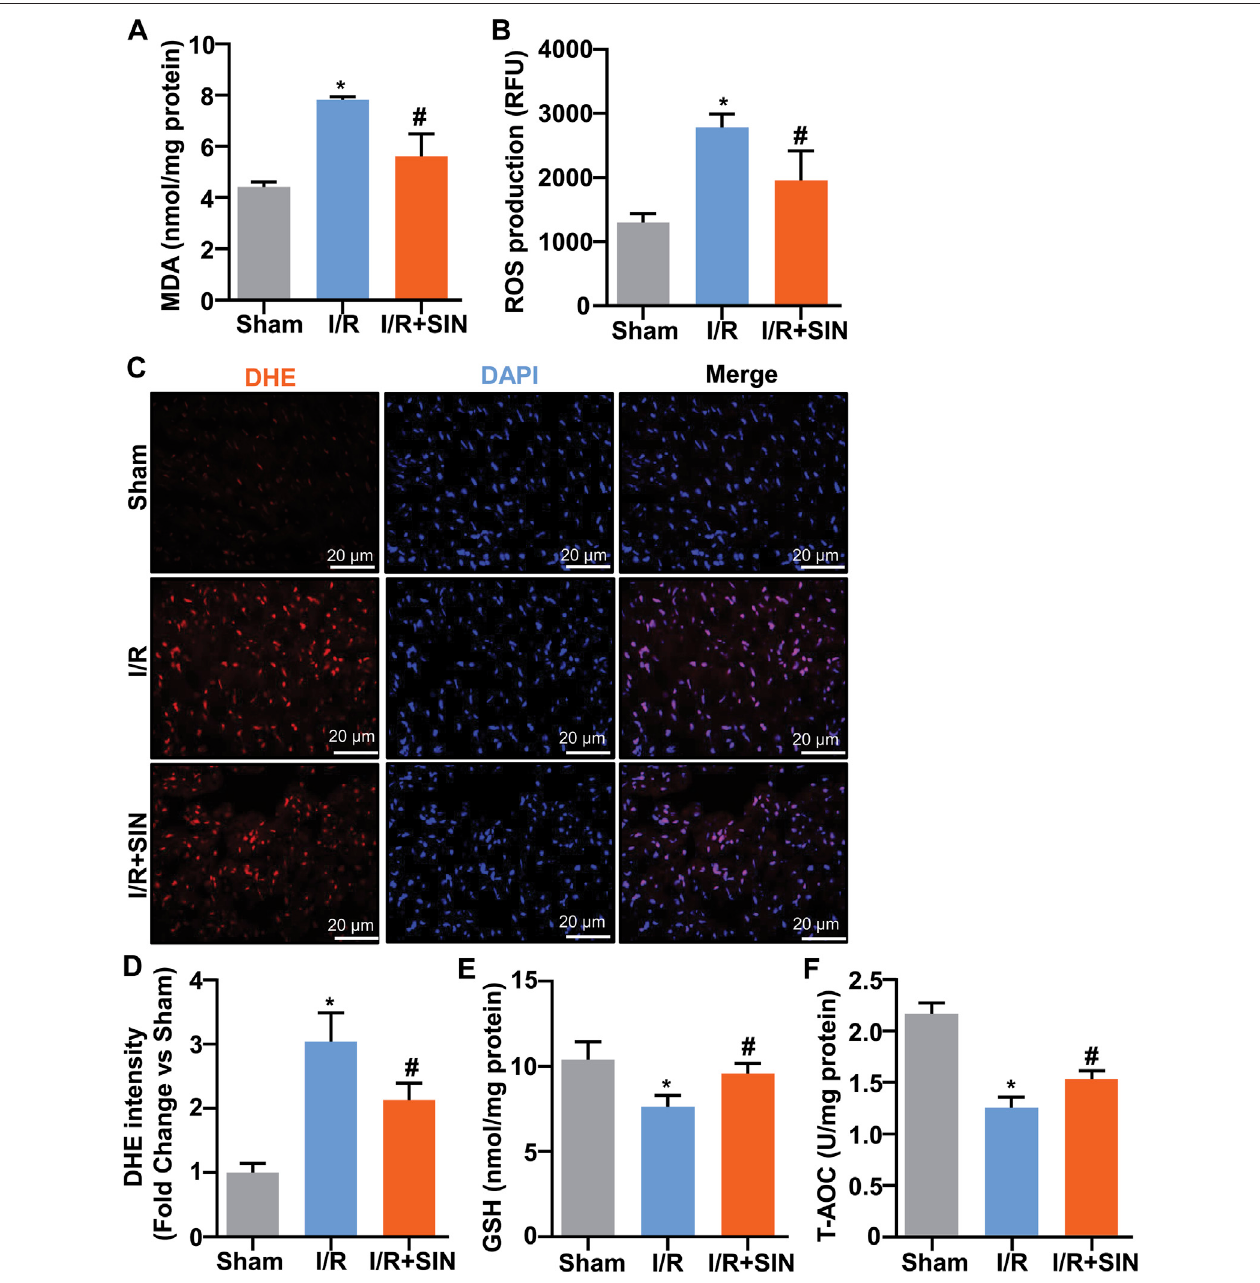
FIGURE 4 | Effect of SIN on parameters re fl ecting oxidative stress in myocardial tissue of MIRI mice. (A,B) Quantitative analysis show that SIN pretreatment prevented the MIRI-induced increase in MDA (A, n = 4) and mitochondrial ROS (B, n = 6) levels in ischemic heart tissue (* p < 0.05 vs. sham, # p < 0.05 vs. I/R). (C,D) QuantitativeanalysisshowthatpretreatmentwithSINpreventedMIRI-inducedincreaseinDHEsignalsinischemichearttissue( n =5,* p < 0.05vs.sham, # p < 0.05vs.I/ R). (E,F) Quantitative analysis showed that SIN pretreatment prevented the MIRI-induced decrease in GSH ( n = 4) and T-AOC ( n = 4) concentrations in ischemic heart tissue (* p < 0.05 vs. sham, # p < 0.05 vs. I/R). Data are shown as means ± SEM.